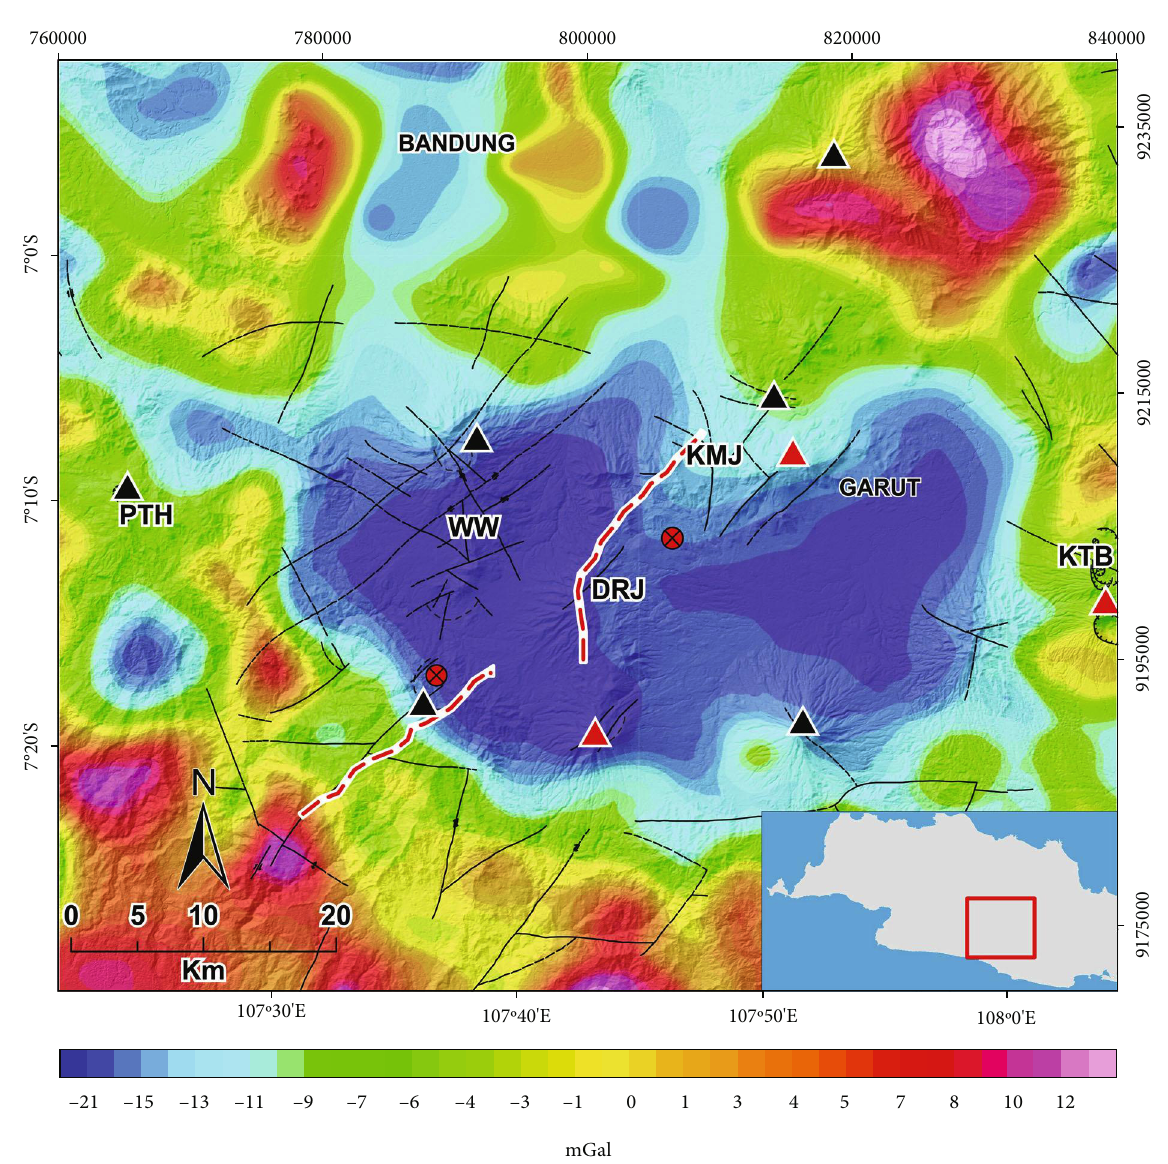
Figure 7: Residual anomaly map for the interest area (dashed blue outline box in Figure 3), along with major geothermal fi elds, PTH=Patuha, WW=Wayang-Windu, DRJ=Darajat, KMJ=Kamojang, KTB=Karaha-Talaga Bodas. Other legends are similar to previously shown